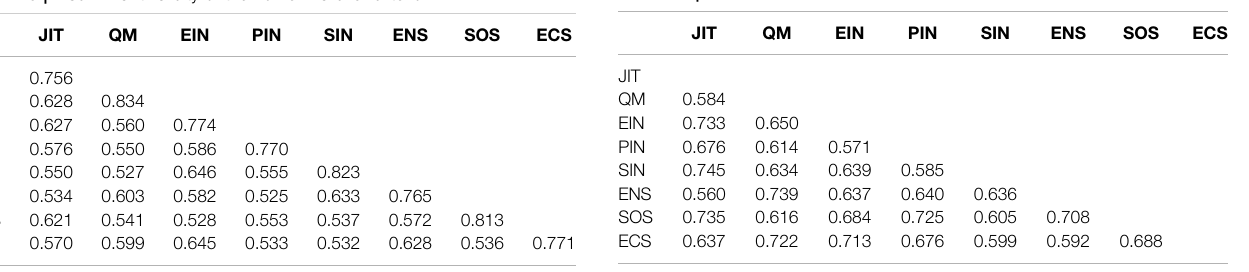
TABLE 6 | Results of HTMT ratio of correlations.